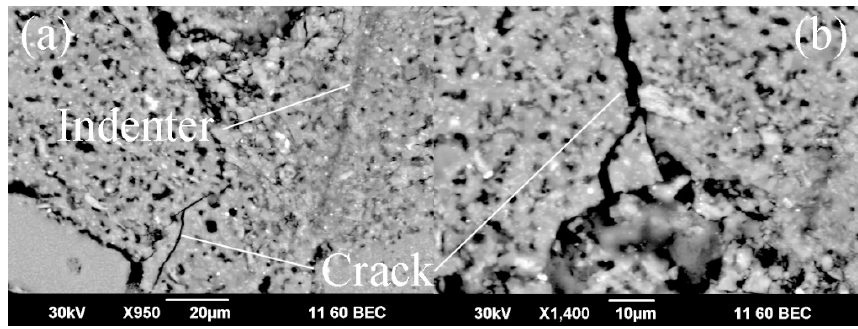
Figure 5. SEM images of crack after HV indenter: ( a ) 950×; ( b ) 1400×.